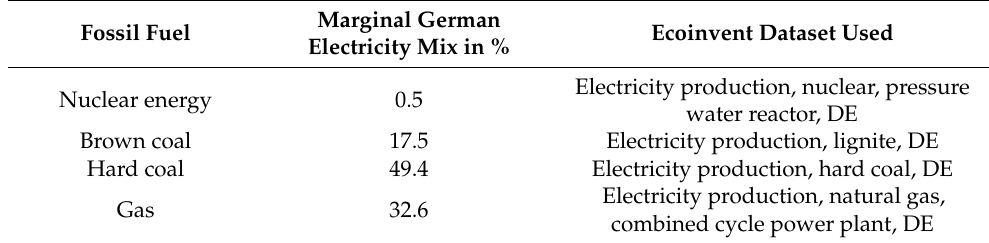
Table 4. Marginal German electricity mix [38].